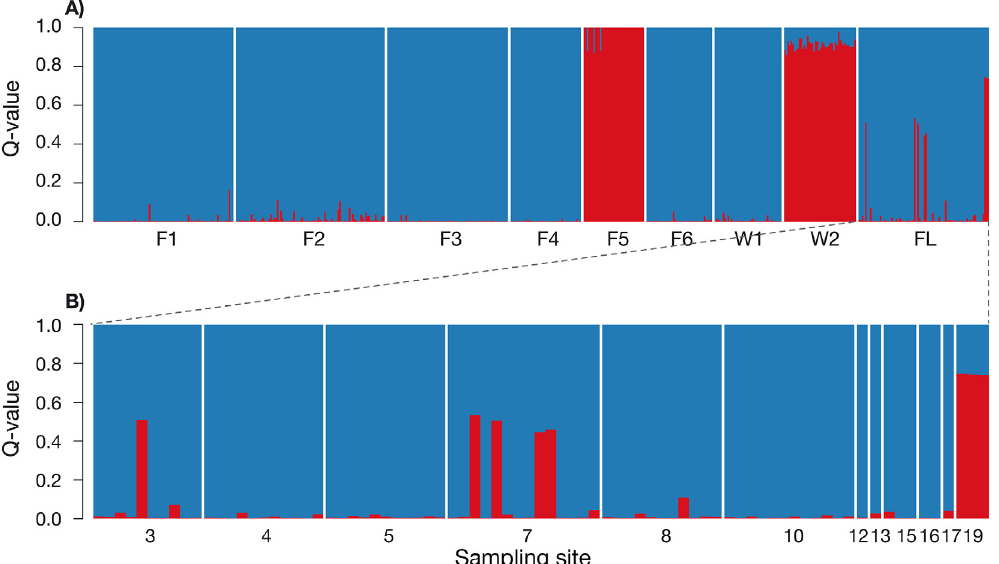
Fig. 4. Genetic structure of reference collections and free-living Atlantic salmon using STRUCTURE K = 2. (A) Q-values among reference collections (F1, F2, and F3: farmed Norway; F4: farmed Ireland; F5: farmed Canada; F6: farmed Scotland; W1: wild Scotland; W2: wild Canada) and free-living Atlantic salmon (FL); (B) Q-values from each sampling site of free-living Atlantic salmon. Red and blue colors represent ancestry to North American and European clusters, respectively